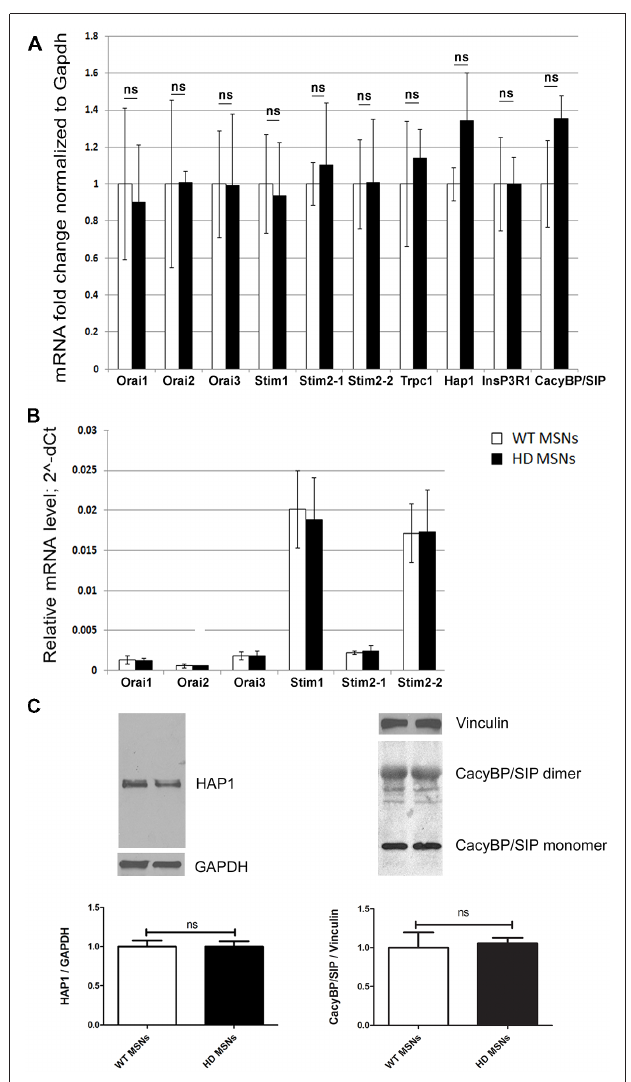
FIGURE 1 | Analysis of mRNA that encode store-operated calcium entry (SOCE) proteins in day in vitro 21 (DIV21) medium spiny neuron (MSN) cultures from YAC128 and wildtype mice. (A) Gene expression analysis of mRNA that encode SOCE proteins and proteins that are involved in Ca 2 + homeostasis in MSNs from wildtype (control) and YAC128 mice using real-time polymerase chain reaction (PCR). The gene expression results for all genes were normalized to Gapdh . Data from wildtype MSNs were normalized to 1. (B) Relative mRNA levels of genes that encode SOCE proteins, measured as 2 ∧ -dCt. (C) Immunoblots of HTT-associated protein-1 (HAP1) normalized to GAPDH and CacyBP/SIP (both monomers and dimers) normalized to Vinculin in YAC128 and wildtype MSN cultures. On the bottom of each panel, the expression levels of HAP1 and CacyBP/SIP proteins are plotted. The results are expressed as mean ± SEM and represent data from three independent mRNA and protein preparations of three different MSN cultures. ns, not